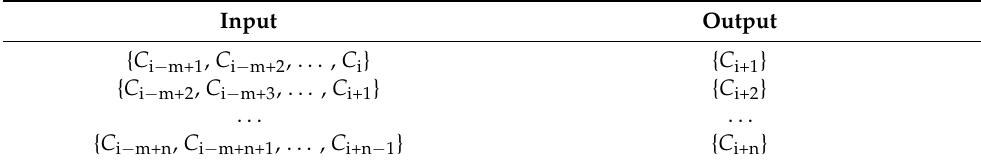
Table 1. Multi-step prediction of neural